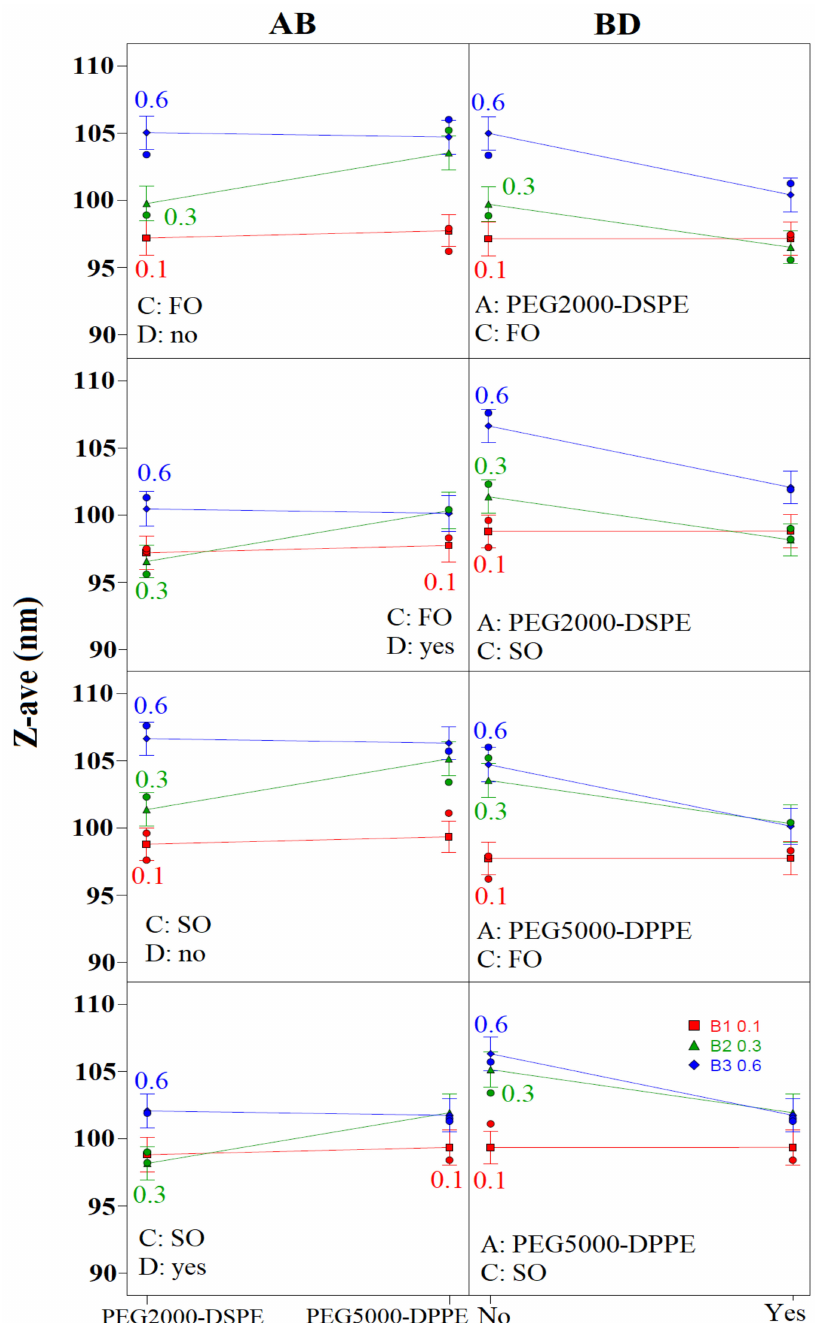
Figure 2. Interaction plot for the mean droplet size (Z-ave). FO: fish oil; SO: soybean oil. AB—PEG-PL type/PEG-PL concentration; BD—PEG-PL concentration/presence of